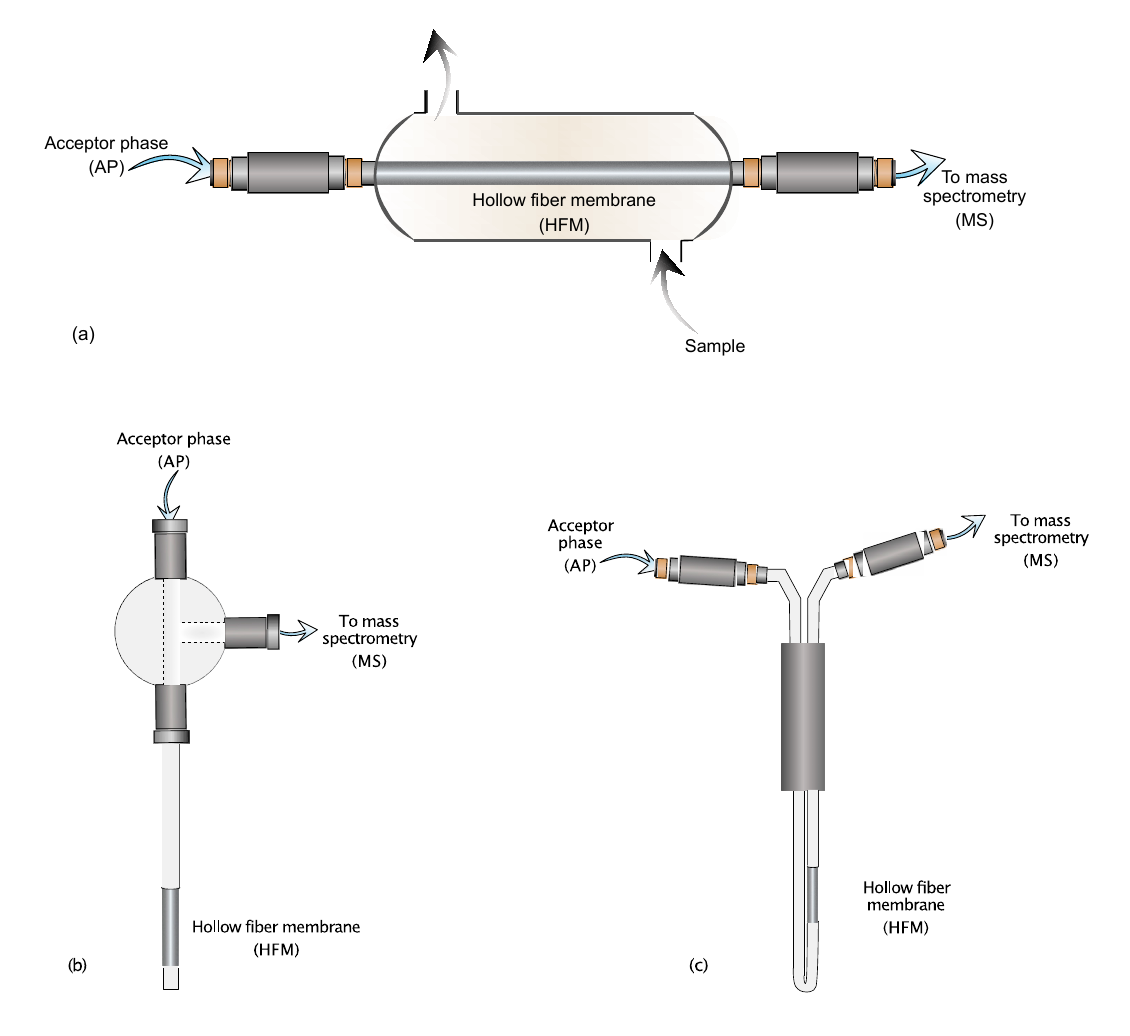
Figure 1. Schematic representation of the CP-MIMS sampling interfaces. ( a ) Flow cell interface; ( b ) Insertion probe variant; ( c ) Immersion probe variant.